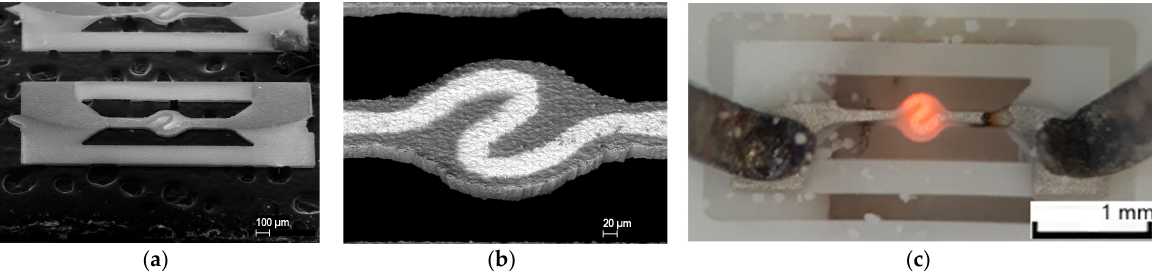
Figure 4. Platinum-sputtered microhotplate: ( a ) SEM image of platinum-sputtered microhotplate on a thin 3YSZ substrate; ( b ) SEM image of hot spot for platinum microheater sputtered by magnetron on a thin 3YSZ substrate; and ( c ) a platinum microheater on 3YSZ membranes under melting point technique evaluation.